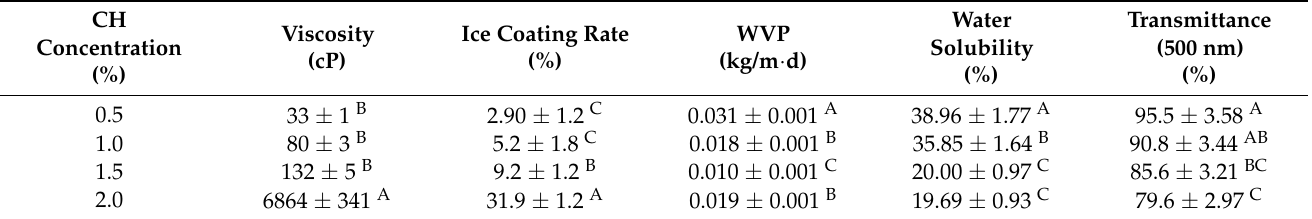
Table 1. Characterization of the physical and chemical properties of the ice solution and coating of fish